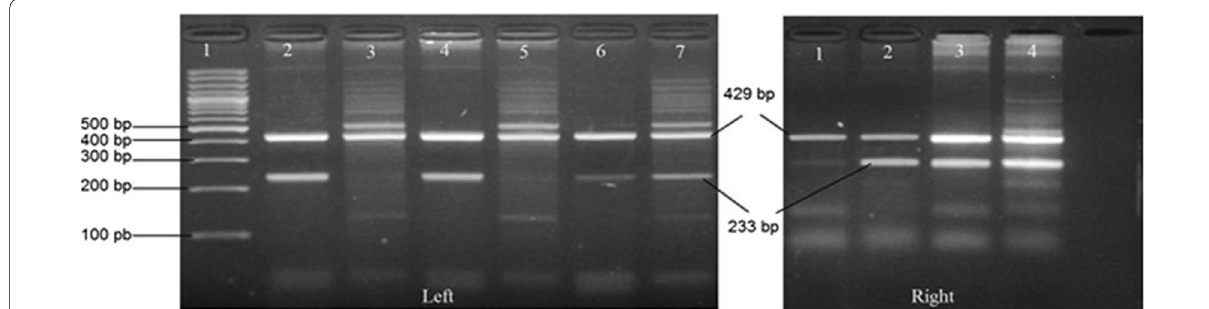
Fig. 2 TGF‑β1 ( 915G/C) PCR product. Left picture: lane 1 showed 100 bp DNA ladder, lanes 2, 3 and lane 4, 5 showed GG genotype whereas the + size of allele band is 233 bp and the control band was 429 bp, Lane 6, 7 showed GC genotype. Right picture: lane 1, 2 showed CC genotype while lanes 3, 4 showed GC